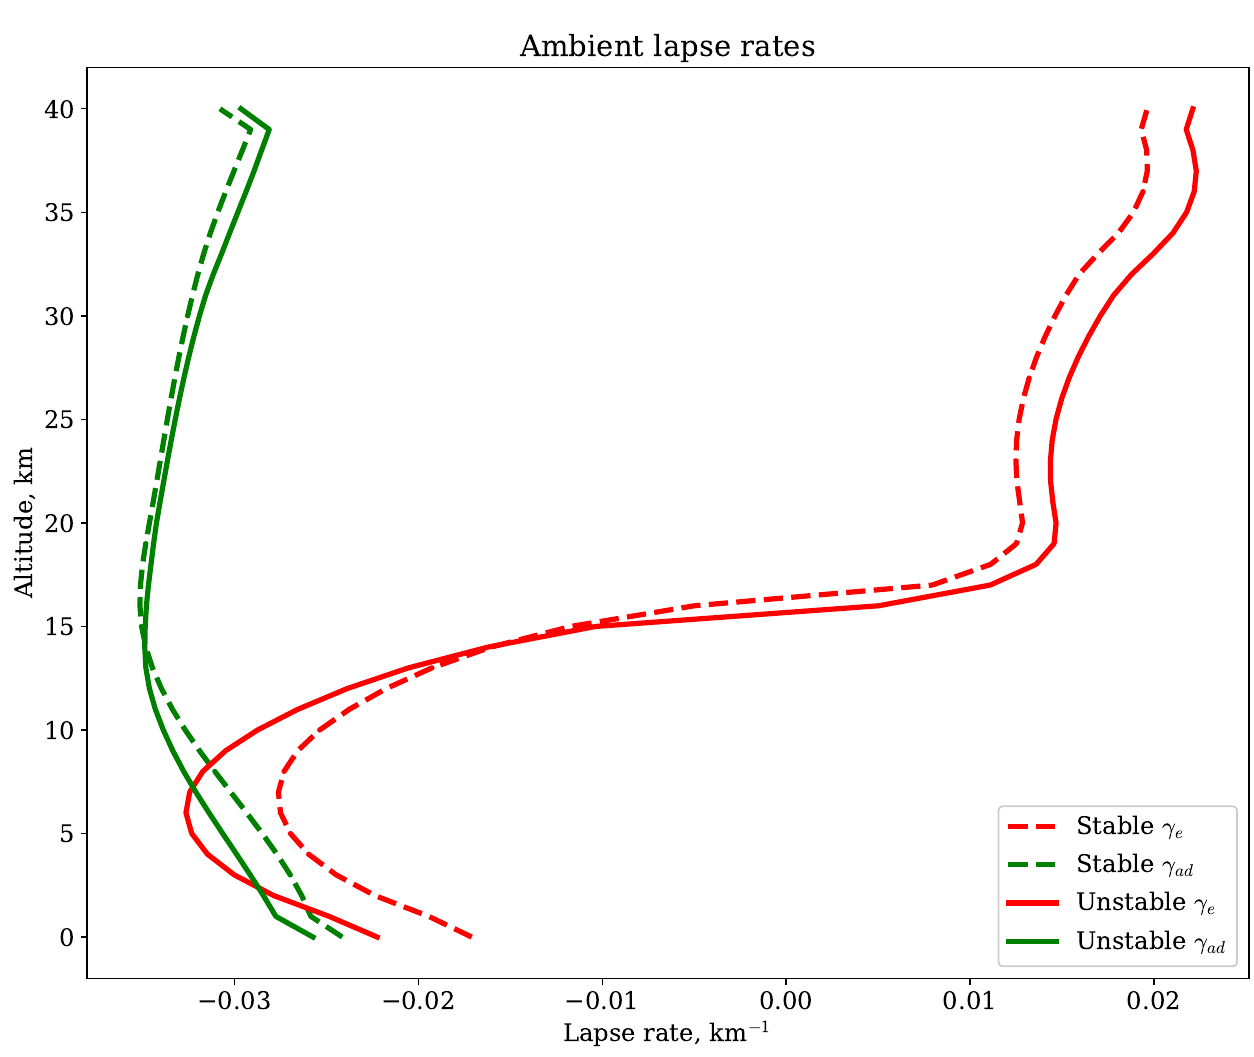
Figure 3. Temperature lapse rate ( γ e ) in red and adiabatic lapse rate ( γ ad ) in green, are shown. The dashed and solid curves correspond to the stable and unstable temperature